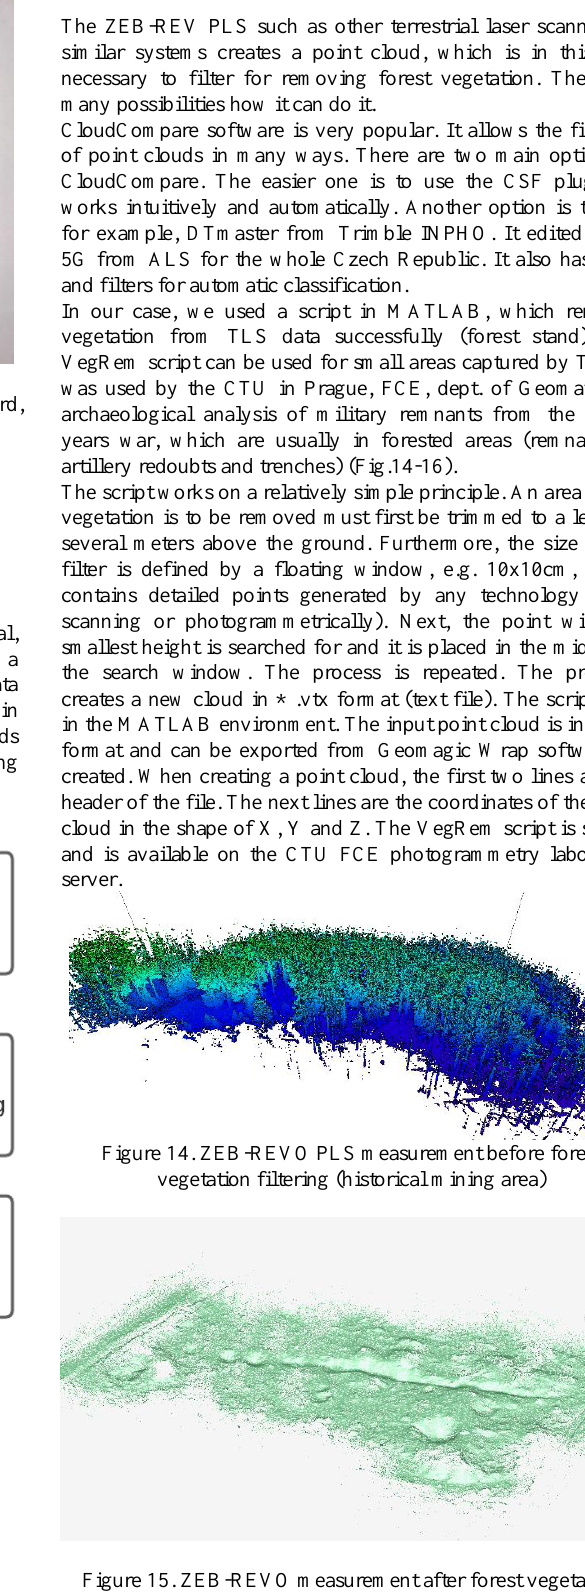
Figure 15. ZEB-REVO measurement after forest vegetation filtering (historical mining